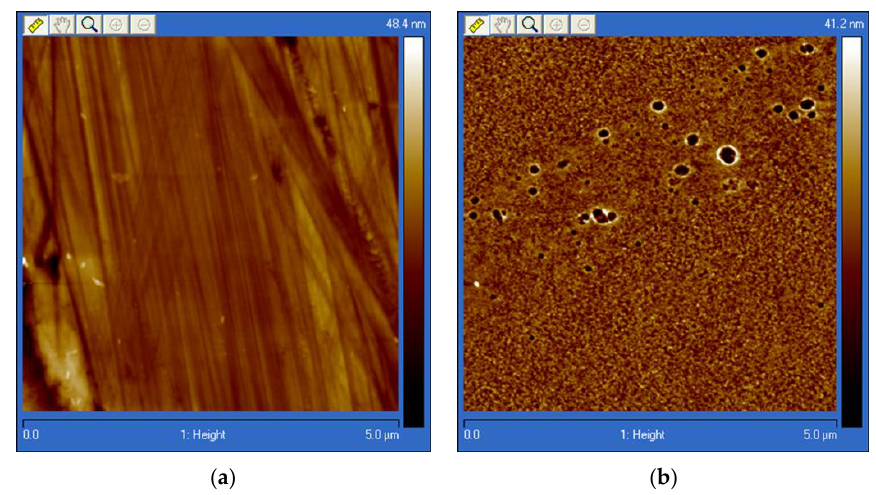
Figure 3. AFM images of the (111) face of diamond ( a ) before irradiation and ( b ) after Ar + ion irradiation with 30 keV at T = 230 °C.